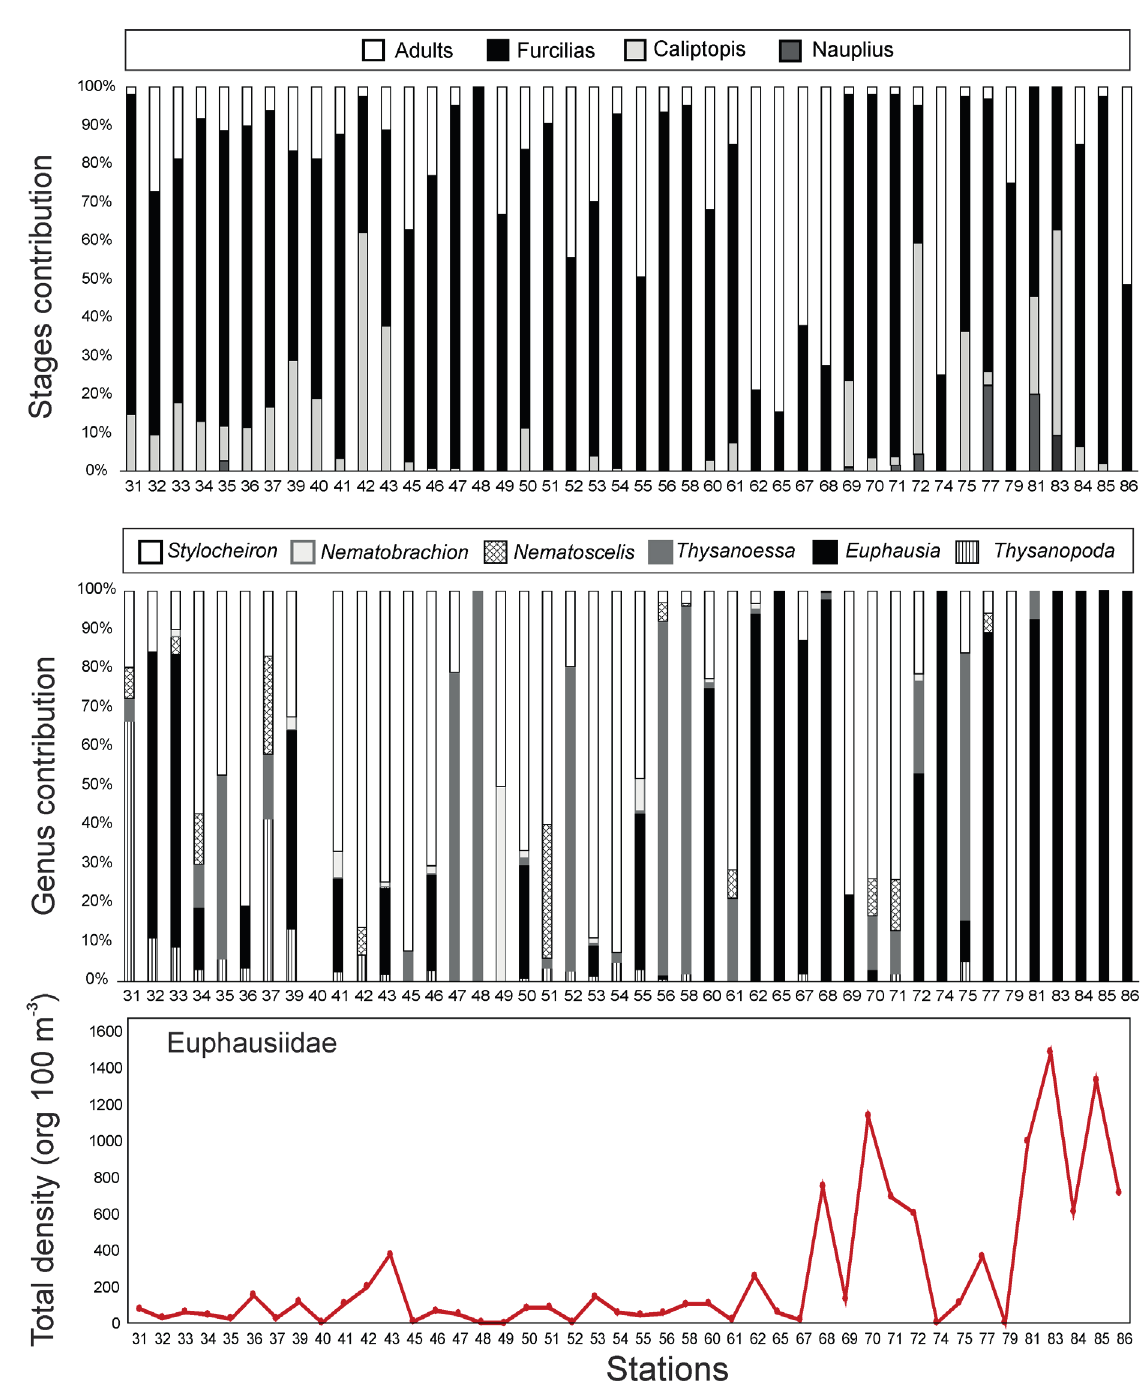
Figure 2 - ( a ) Percentage contribution of each euphausiid stage; ( b ) percentage contribution of each euphausiid genus and; ( c ) euphausiid total density (organisms 100 m -3 ) at each station along the 30° S transect through the South Atlantic